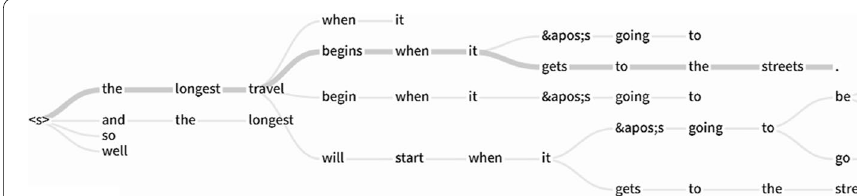
Fig. 3 Beam search decoding.